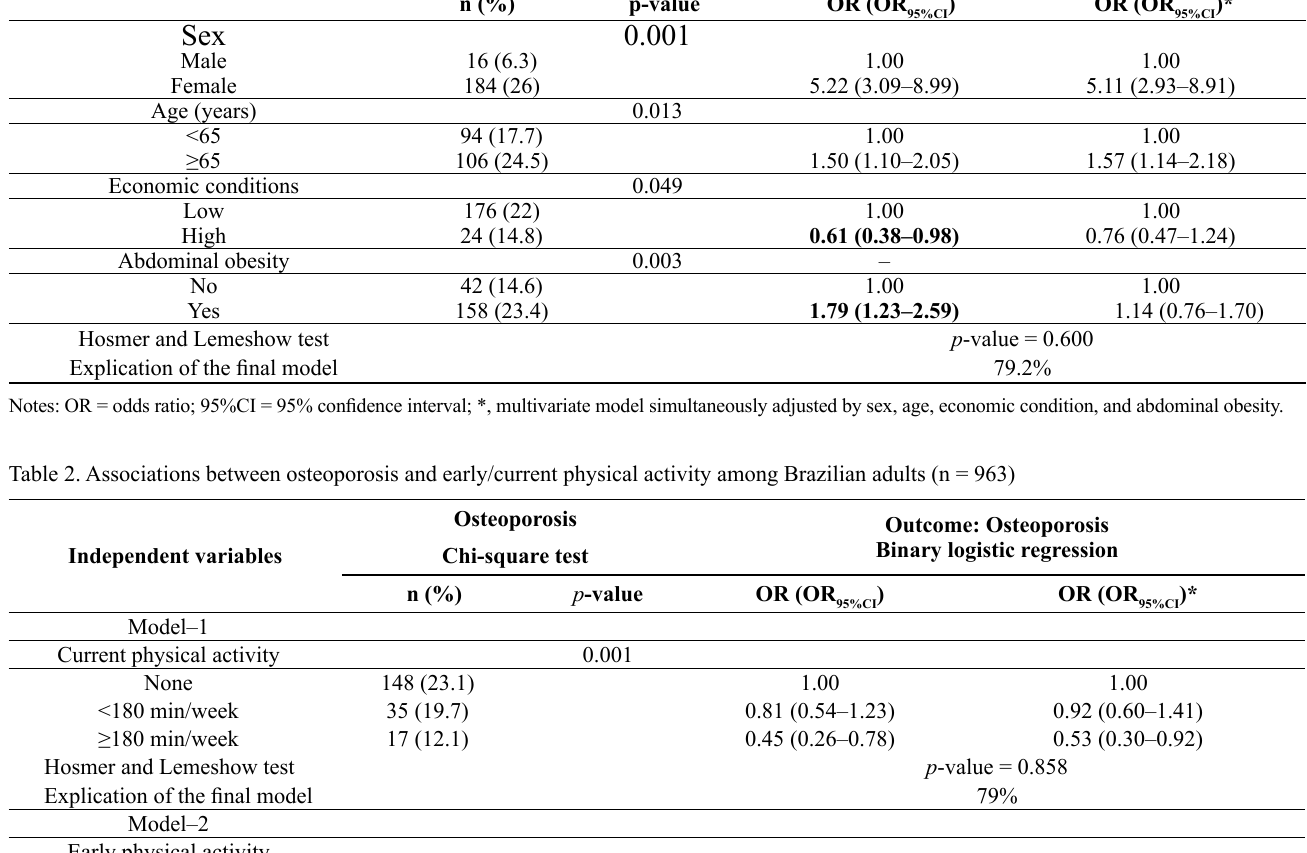
Table 3. Associations between osteoporosis and sex according to sport participation in childhood and/or adolescence (n = 963). Sports participation in childhood/ adolescence None Period (n =